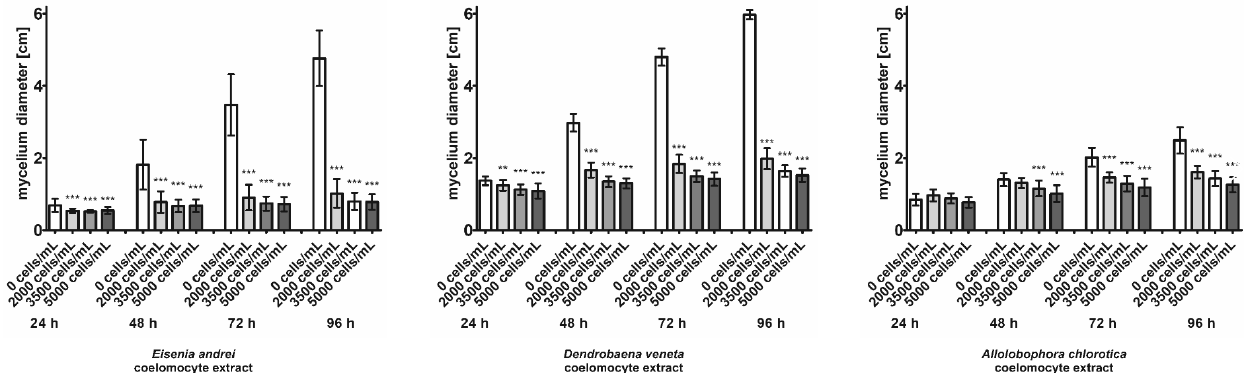
Figure 7. Growth (mean diameter ± SD) of Rhizoctonia solani mycelium 24, 48, 72 and 96 h after treatment with Eisenia andrei , Dendrobaena veneta and Allolobophora chlorotica coelomic fluid extracts. Significant differences between control and groups treated with coelomocyte extracts are labeled with ** ( p < 0.01) and *** ( p < 0.001).